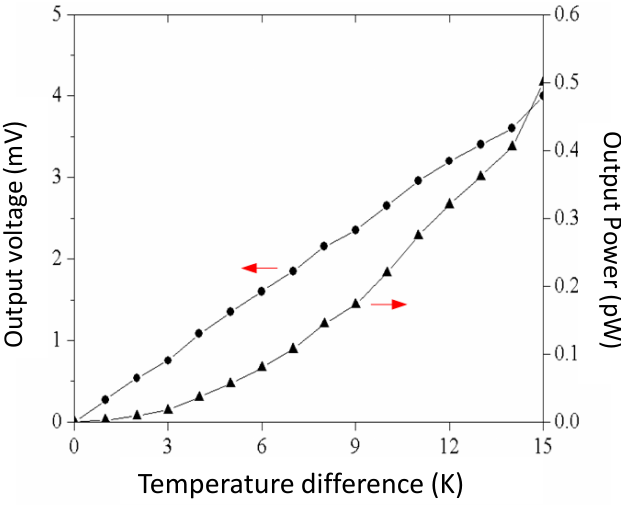
Figure 8. Measured output voltage and power of the thermoelectric energy harvester.